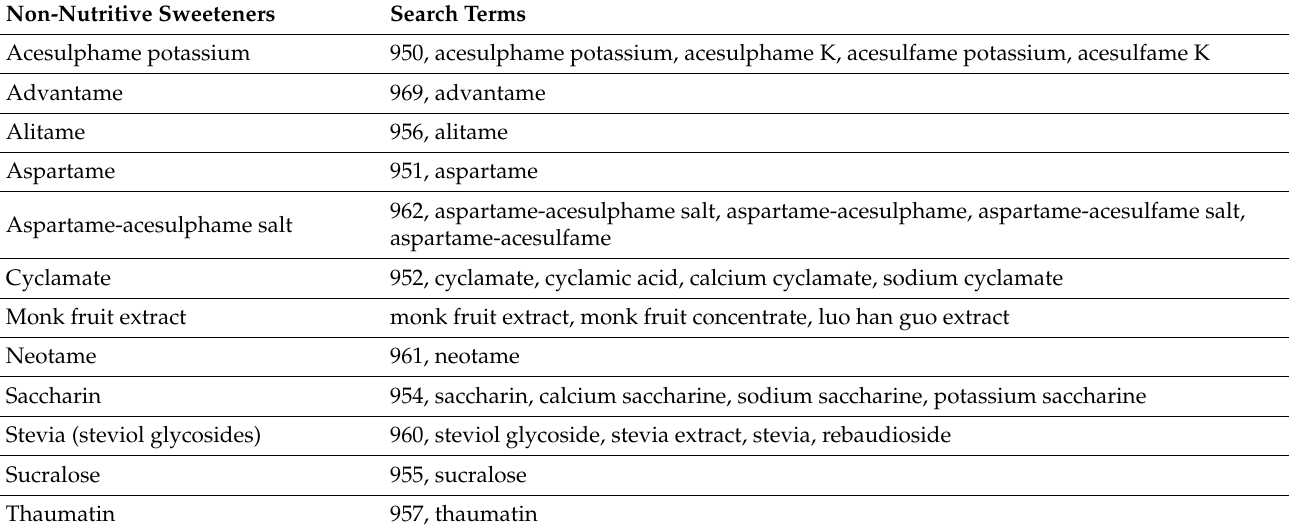
Table 1. Non-nutritive sweeteners (NNS) and search